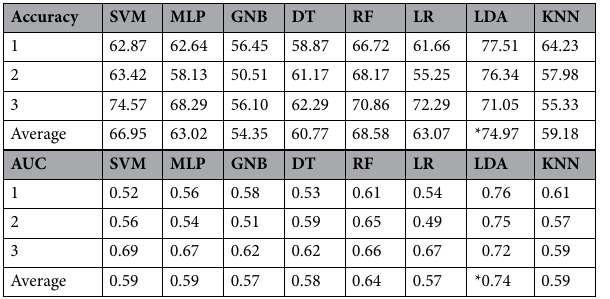
Table 4. Results of ML analysis (eight methods) of BPW indices for discriminating between robust + no-MetS and possible sarcopenia (dynapenia + presarcopenia + sarcopenia). The accuracy is in %. The accuracy and AUC values are listed for the threefold cross validation. Asterisks indicate the highest average value. Both accuracy and AUC were highest for